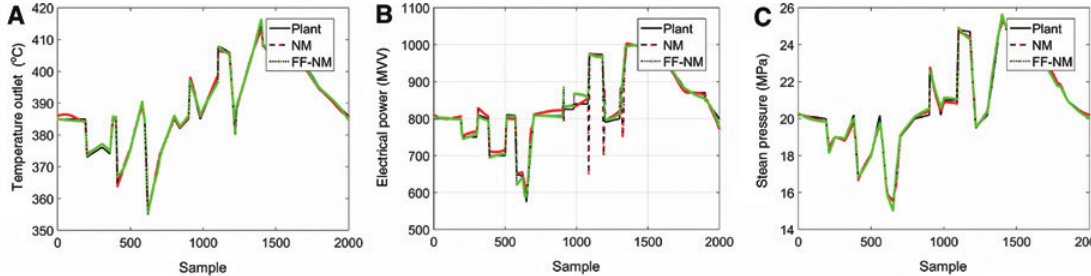
Figure 4: Correlation between the Output of Different Models from Test Case 1.